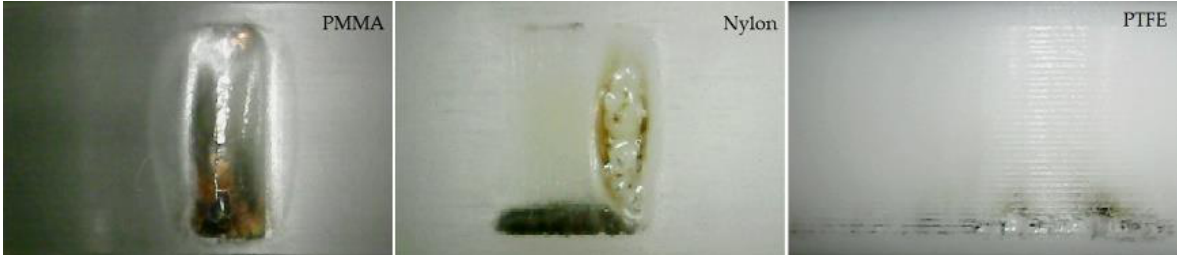
Figure 18. Surface damage of different materials under 50 Hz RMPs.